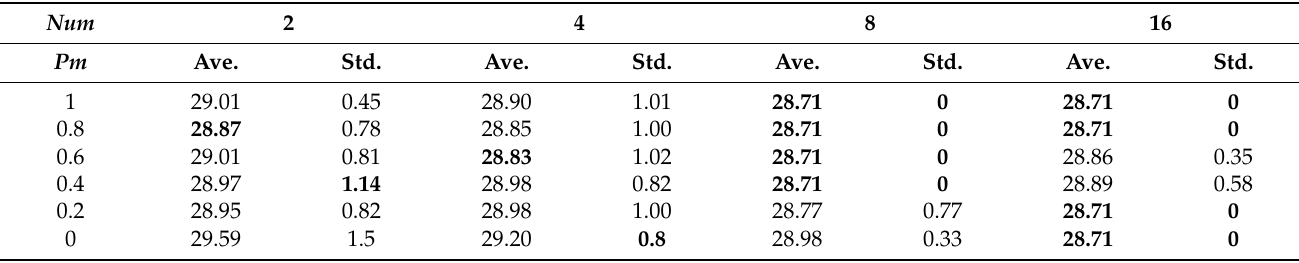
Figure 17. Average objective function values with different Num and P m in scenario 1: ( a ) Num = 2; ( b ) Num = 4; ( c ) Num = 8; ( d ) Num = 16. Table 5. Objective function value with different Num and P m in scenario